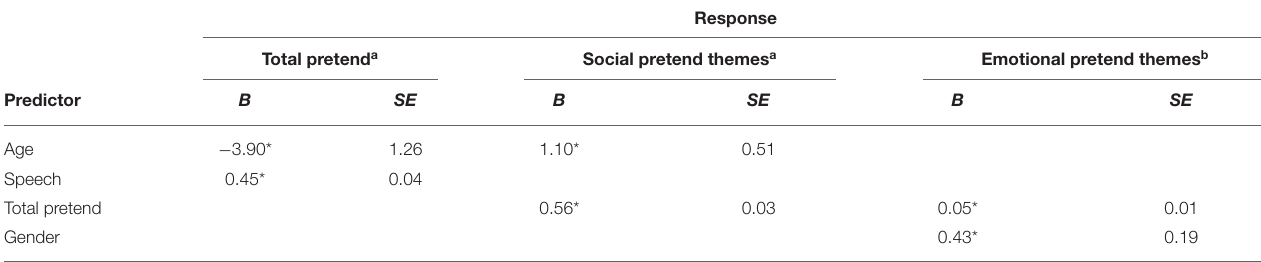
TABLE 2 | Multilevel model parameter estimates for age and gender differences in three pretend variables ( N = 54 dyads).